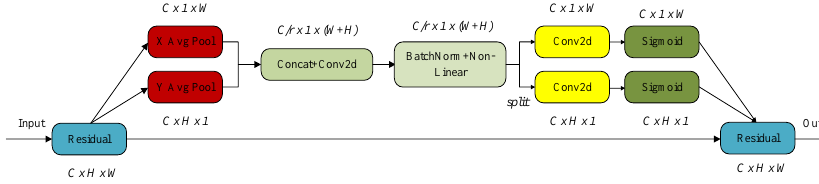
Figure 2. The architecture of coordinate attention.